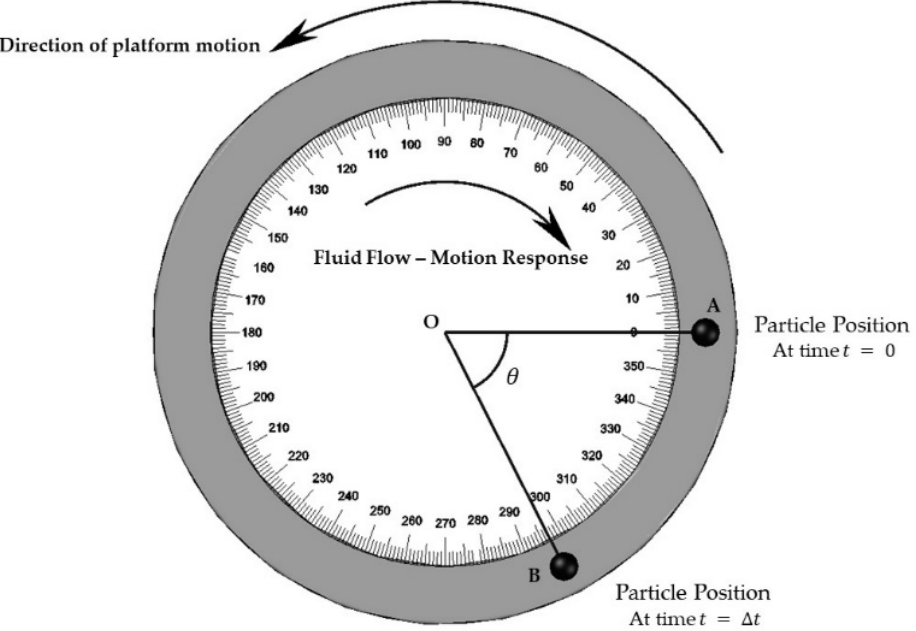
Figure 2. Schematic for flow channel and particle tracking concept.